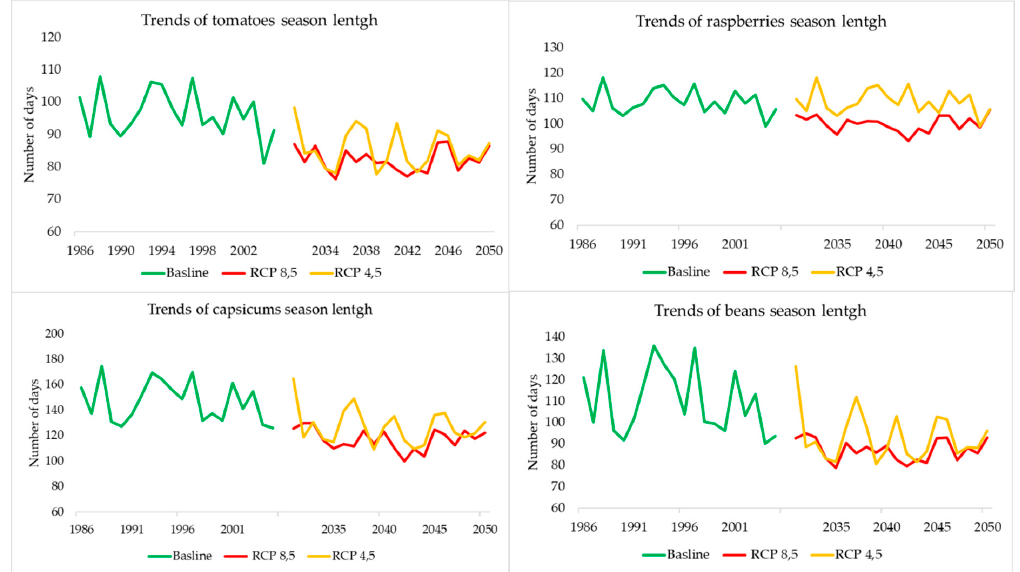
Figure 8. Length of crop season (number of days) for tomatoes, beans, capsicums, and raspberries as projected under RCP 4.5 and RCP 8.5 emission scenarios.